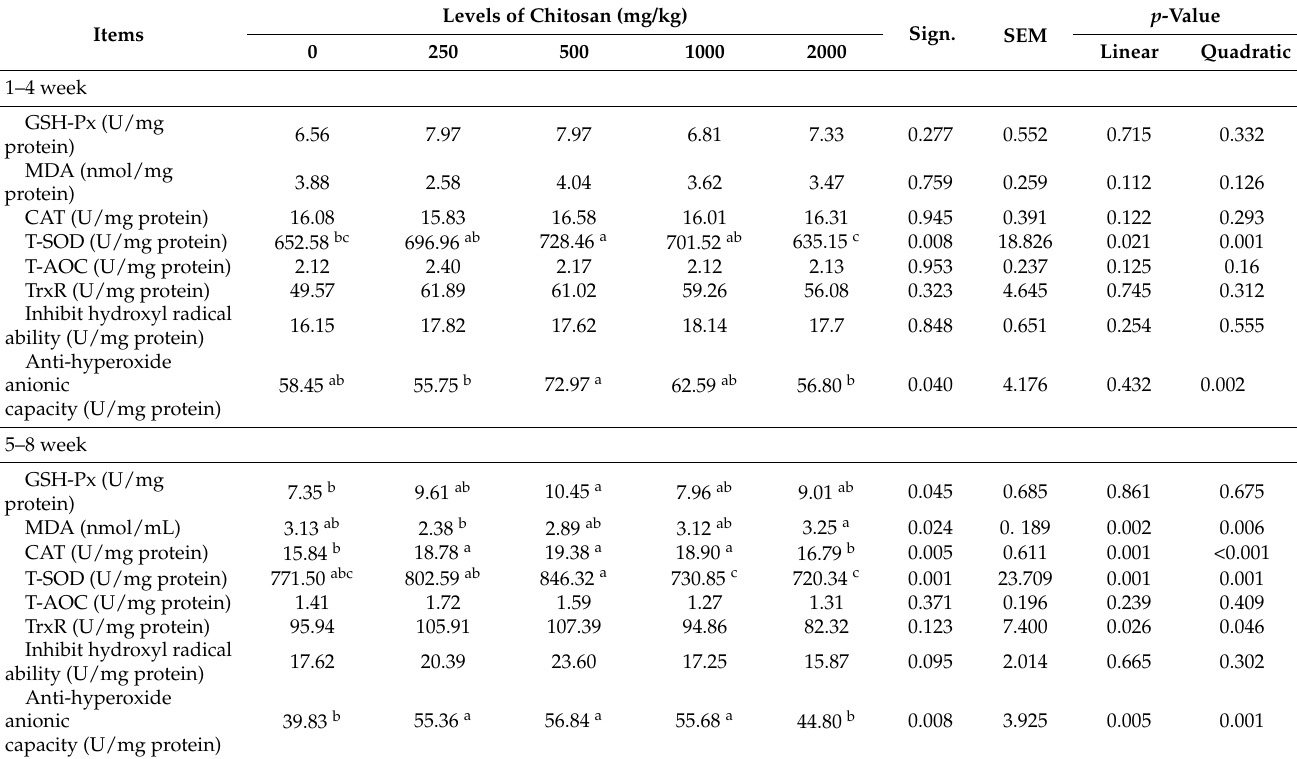
Table 5. Effect of dietary chitosan supplementation on liver antioxidant variables of laying